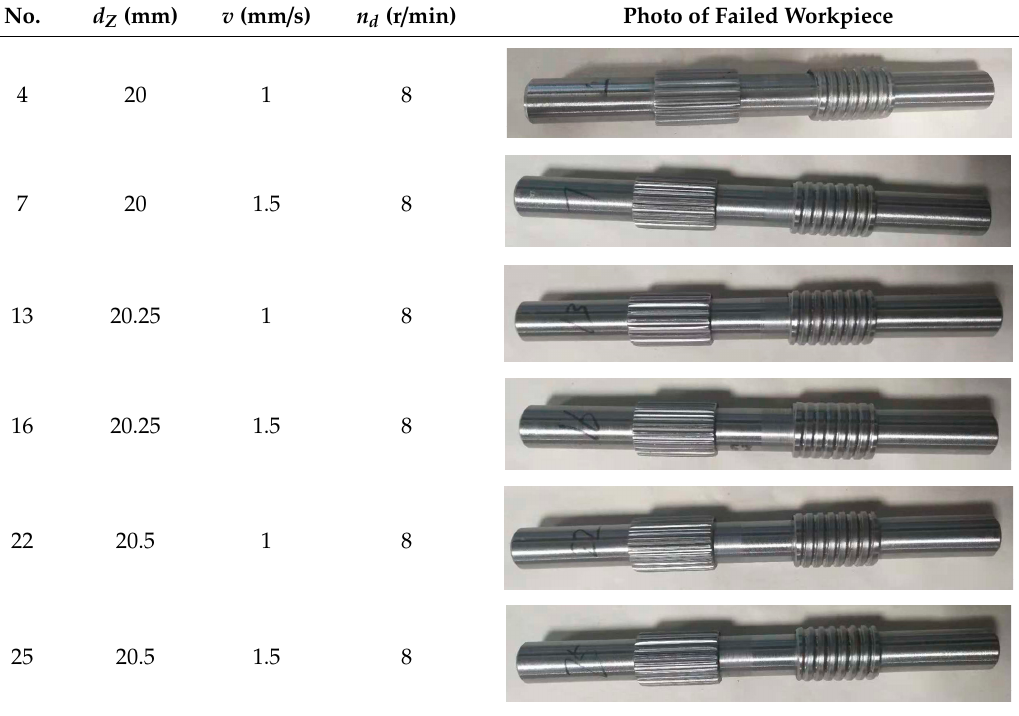
Table 5. Failed workpiece by synchronous rolling.